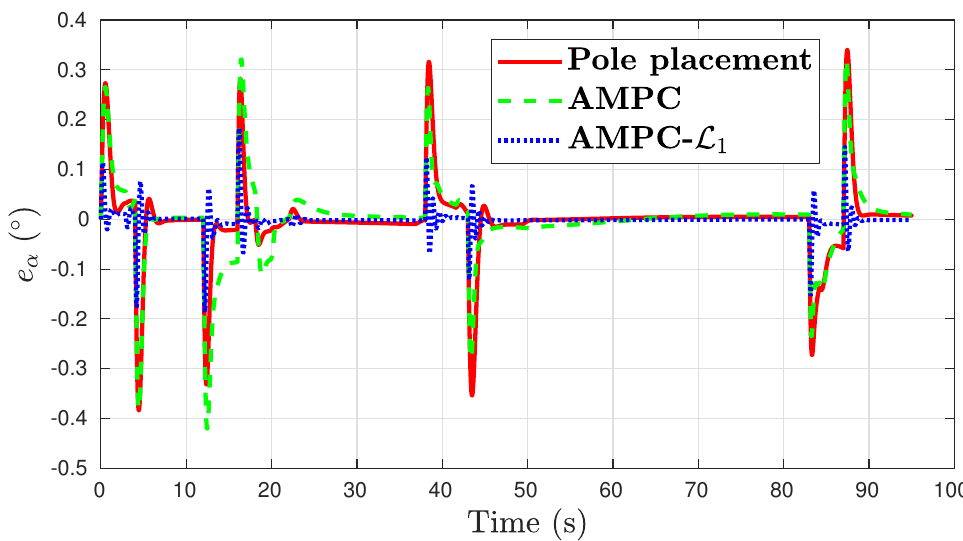
Figure 3. Angle-of-attack tracking error for nominal case.